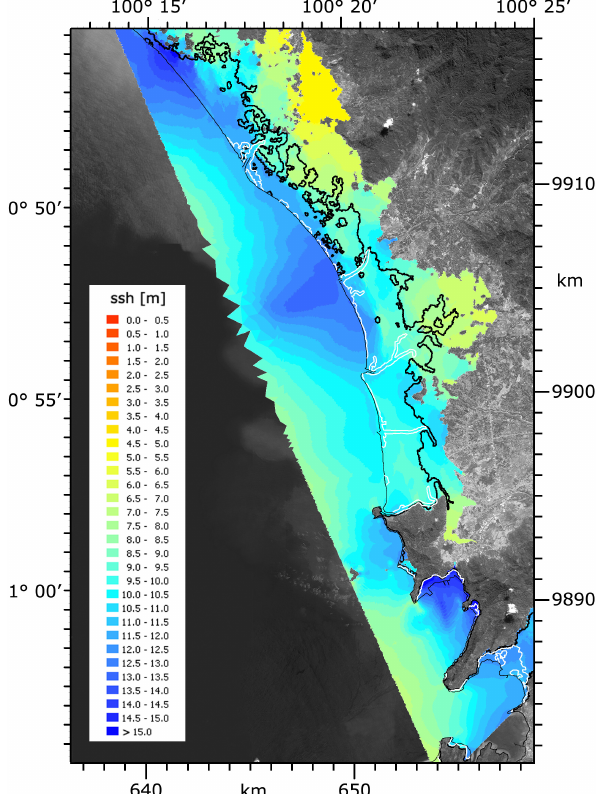
Fig. 11. Worst case scenarios for Padang. Coloured area: sea sur- face heights of scenario 095 12 mw9.0, thick black line: inunda- tion of scenario 095 14 mw8.5, white line: inundation of scenario 095 14 mw8.0, thin black line: coast. of all scenarios of magnitude 8.5 (black lines) and of magni- tude 8.0 (white lines) for each of the priority areas Padang, Cilacap, and Kuta, respectively. The scenarios are named ac- cording to their epicentres. The first digits give the location along the Sunda Trench (starting with 1 at the south-eastern end), the following digits give the location with respect to